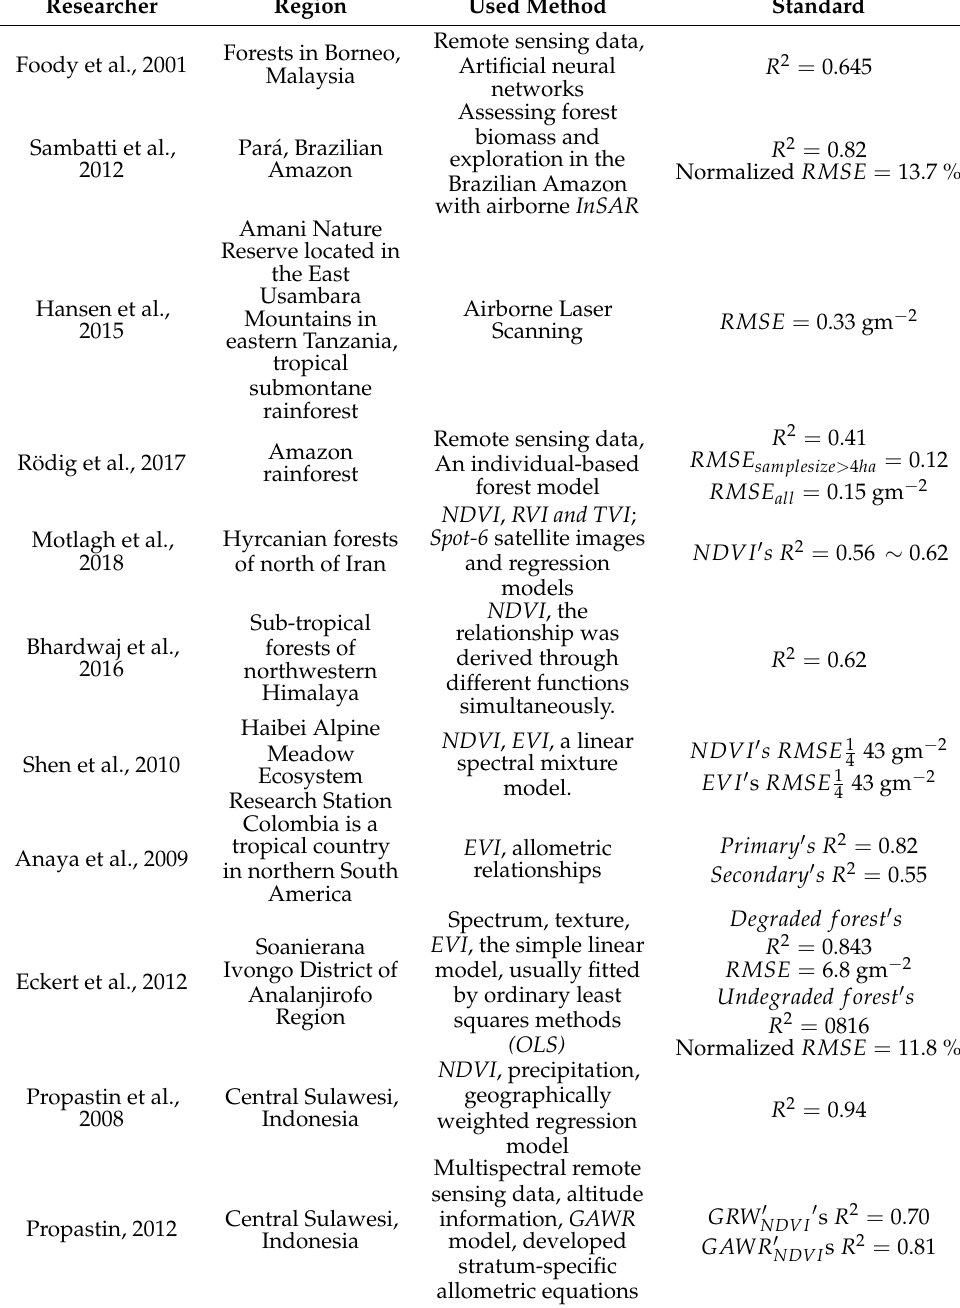
Table 4. Comparative analysis of forest biomass estimation with remote